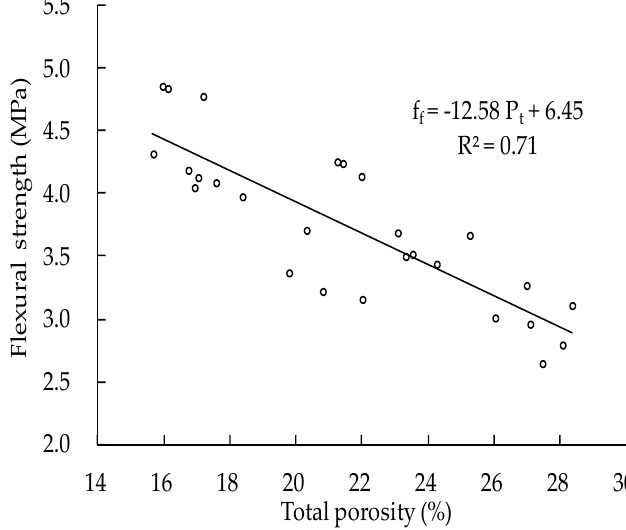
Figure 11. Relationship between flexural strength and total porosity.